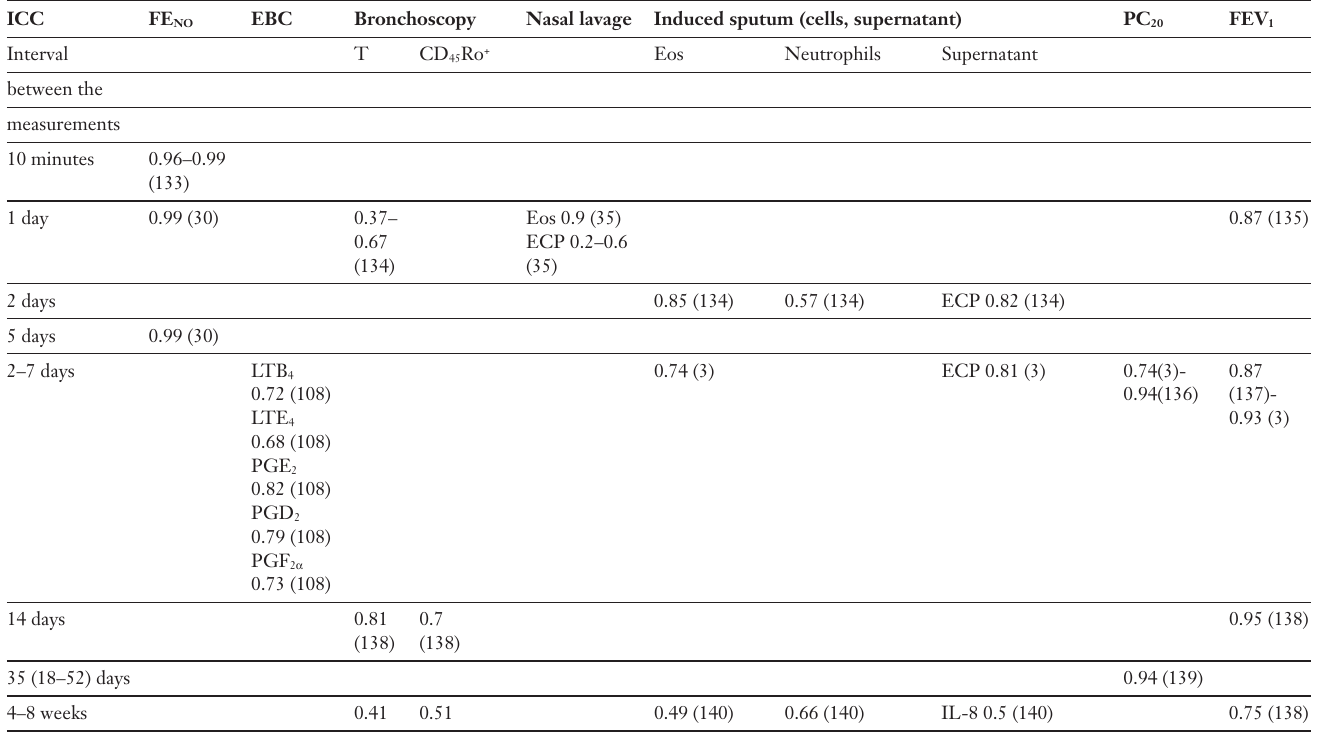
Reproducibility of different methods of airway inflammation